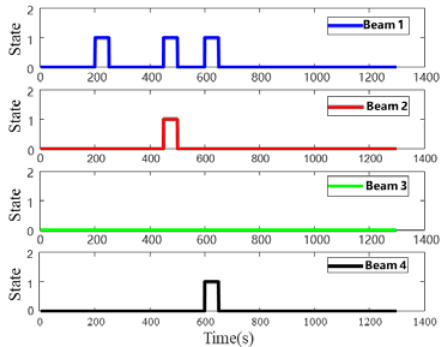
Figure 9. Beam state change process.